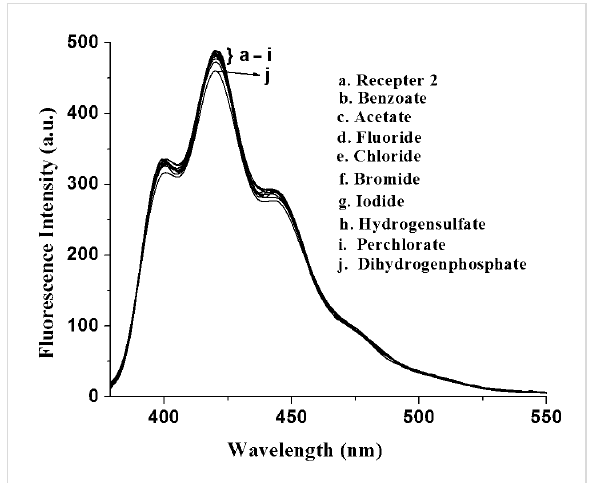
Figure 8: Change in fluorescence emission of 2 ( c = 3.93 × 10 − 5 M) in the presence of 1 equiv of tetrabutylammonium salts of different guests in CH 3 CN.